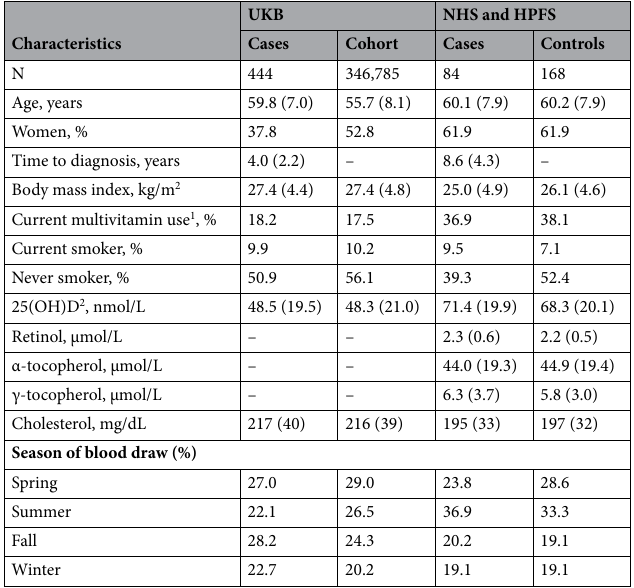
Table 1. Characteristics of participants in the fat-soluble vitamin and risk of glioma analysis in the UK Biobank, Nurses’ Health Study, and Health Professionals Follow-Up Study. Continuous variables presented as mean (SD) and categorical variables as percentages (%). 25(OH)D 25-hydroxyvitamin D, HPFS Health Professionals Follow-Up Study, NHS Nurses’ Health Study, UKB United Kingdom Biobank. –Denotes not applicable or data not available. 1 UKB multivitamin use prevalence includes participants who reported multivitamin or mineral use. 2 Season-standardized